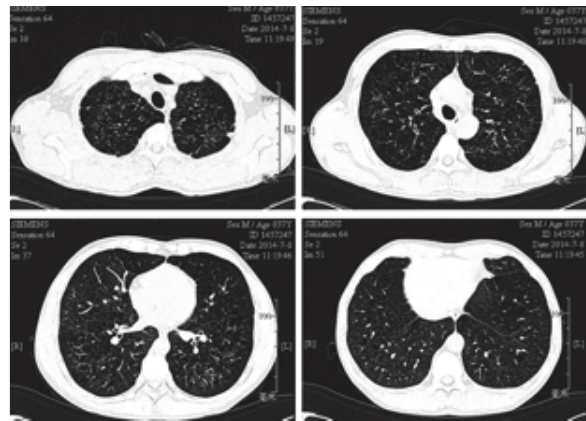
Figure 1: Thoracic HRCT showed a bilateral diffuse cyst, especially in upper lobe and middle lobe.